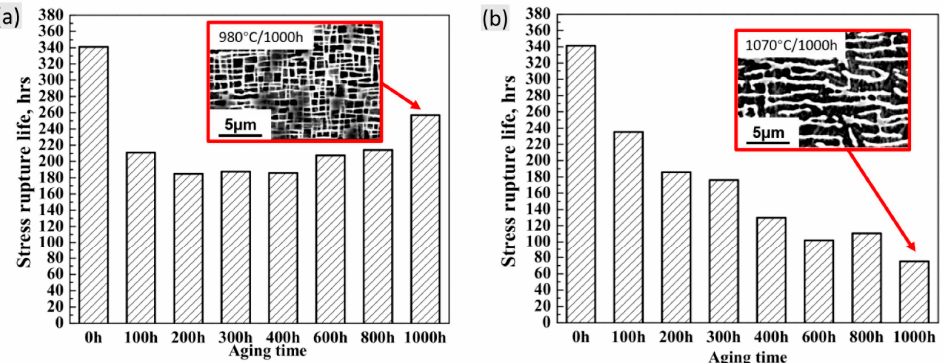
Figure 18. Effects of exposure time on the stress rupture life of DD6 alloy at 1070 ◦ C/140 MPa after long-term exposure at ( a ) 980 ◦ C and ( b ) 1070 ◦ C. The associated microstructures after thermal exposure are also presented [34].